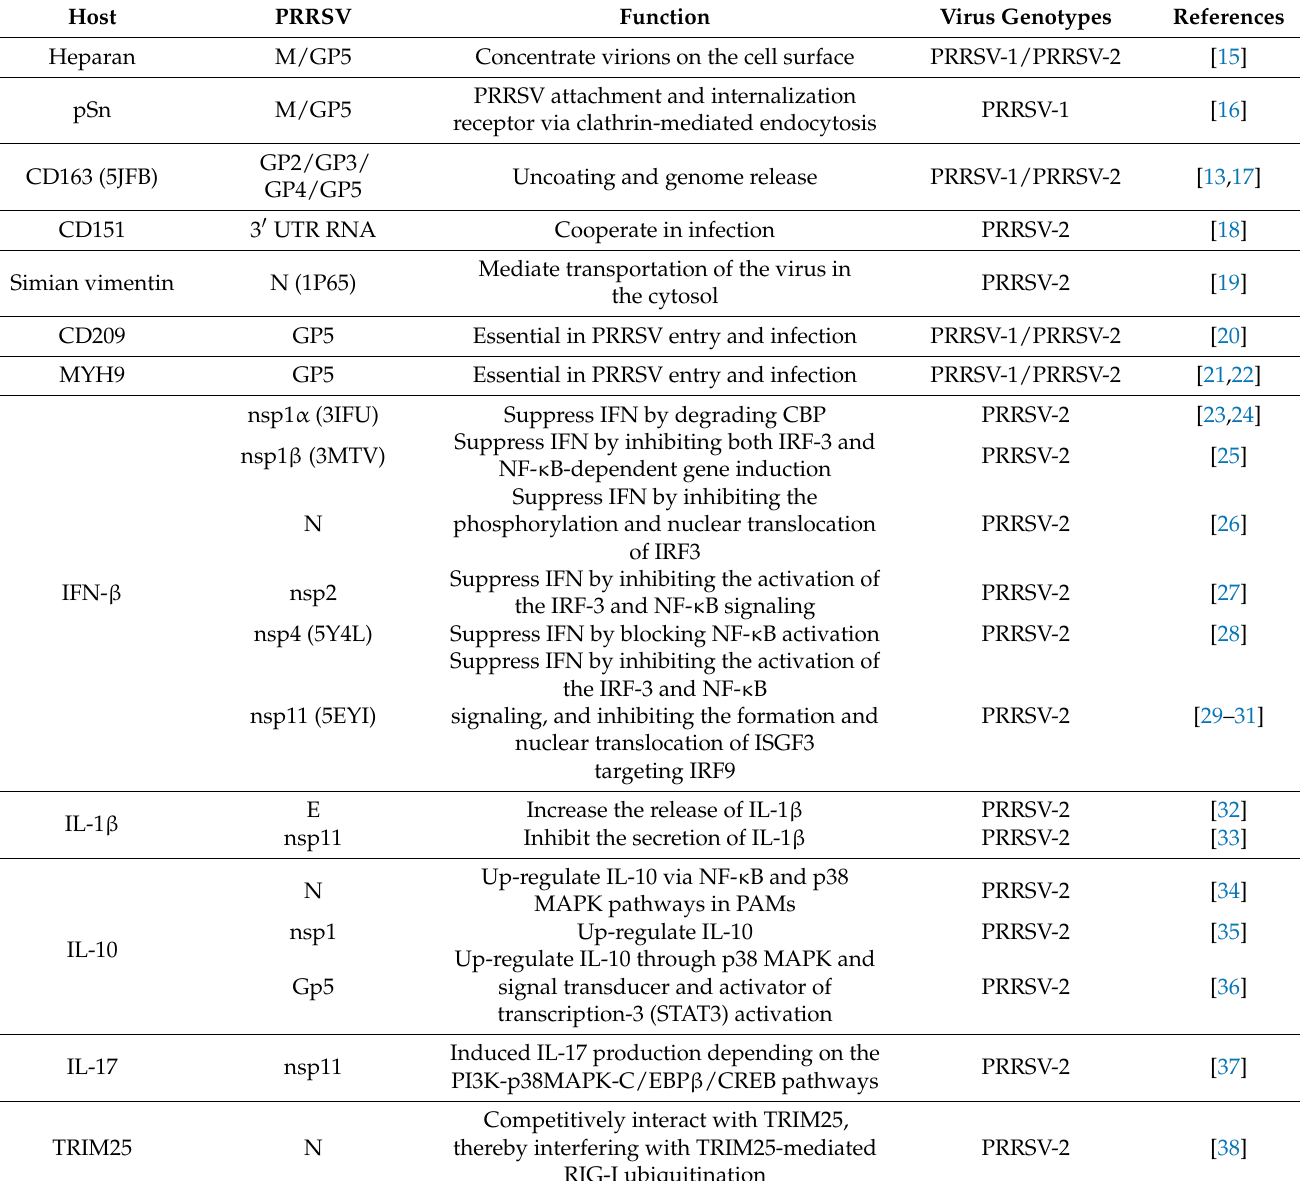
Table 1. List of porcine reproductive and respiratory syndrome virus (PRRSV)–host interactions and their functions. Protein data bank (PDB) codes of structures are enclosed in the